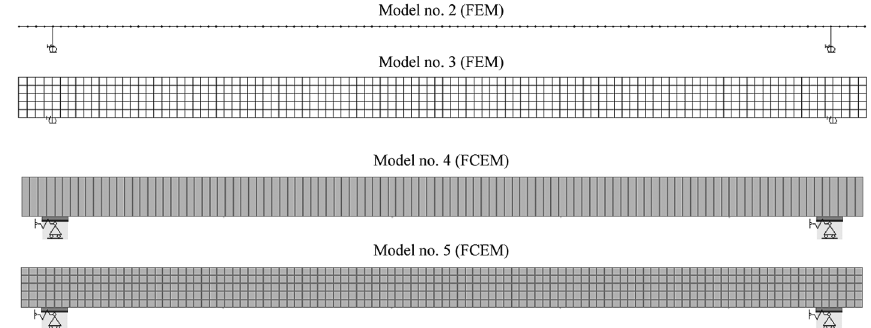
Fig. 5. RC beam models adopted for the structural analysis carried out with FEM and FCEM